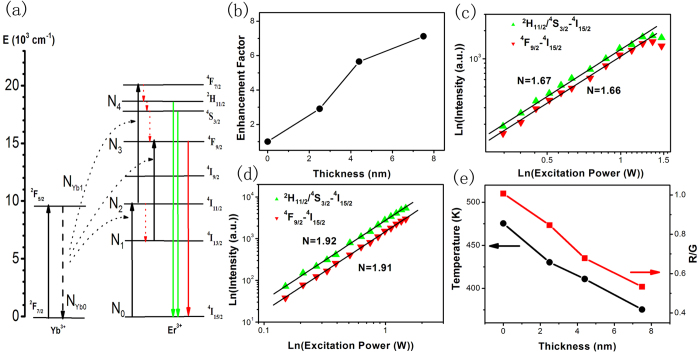
(a) Schematic of UC populating mechanism for NaYF4:Yb,Er under 980 nm excitation. (b) EF of Ag nanocube@NaYF4@NaYF4:Yb,Er versus different intermediate NaYF4 thickness, comparing with Ag nanocube@NaYF4:Yb,Er, (The excitation power of ~0.33 W). (c,d) Power dependent UCL intensity of different transitions in Ag nanocube@NaYF4:Yb,Er and Ag nanocube@7.5 nm NaYF4@NaYF4:Yb,Er, respectively. (e) Temperature calculated based on branch ratio (RHS) of 2H11/2-4I15/2 to 4S3/2-4I15/2 transitions, and the ratio between red emission and green emission (R/G) in different Ag-nanocube@NaYF4@NaYF4:Yb,Er samples versus different intermediate NaYF4 thickness.